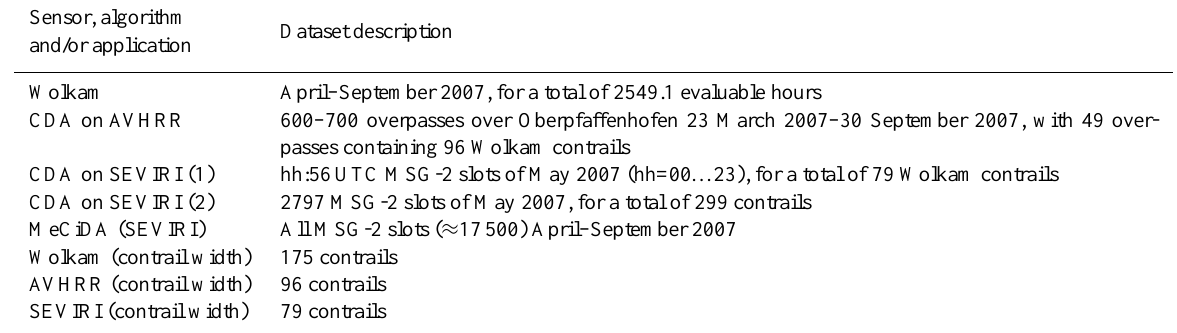
Fig. 1. Contrail scene of 16 April 2007, 12:02UTC, as recorded by the Wolkam camera. (a) The original picture taken by the Wolkam all-sky camera. (b) The Wolkam picture after it has been deskewed, mapped on a plane, and aligned to the cardinal points. Here, 11 contrails could be identified and marked with numbers from 1 to 11. Table 1. Summary of the Wolkam, AVHRR and SEVIRI datasets. Sensor,